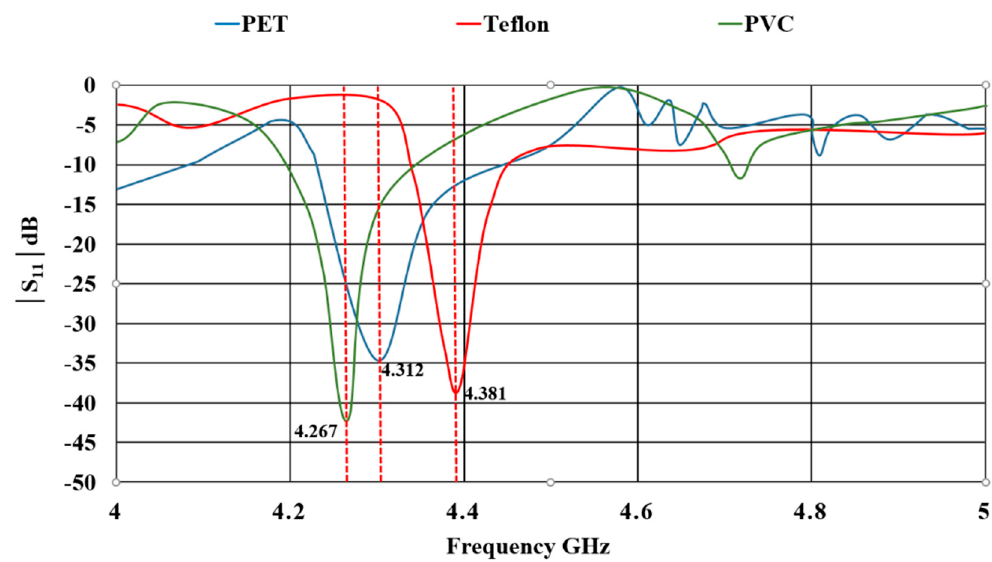
Figure 10. Reflection coefficients of E-shaped flexible polymer substrate antennas on PET, Teflon, and PVC substrates operating at 4.25 GHz.